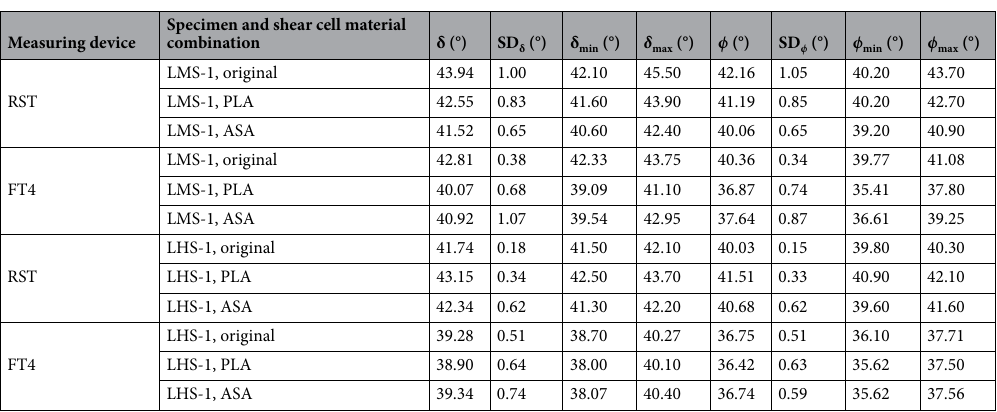
Table 3. Shear test results – effective angle of internal friction δ and linearized angle of internal friction ϕ .